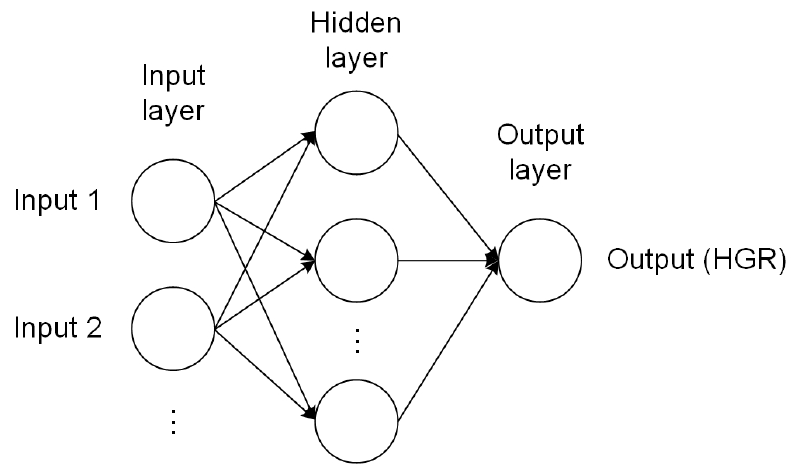
Figure 1. Architecture of the ANN model.